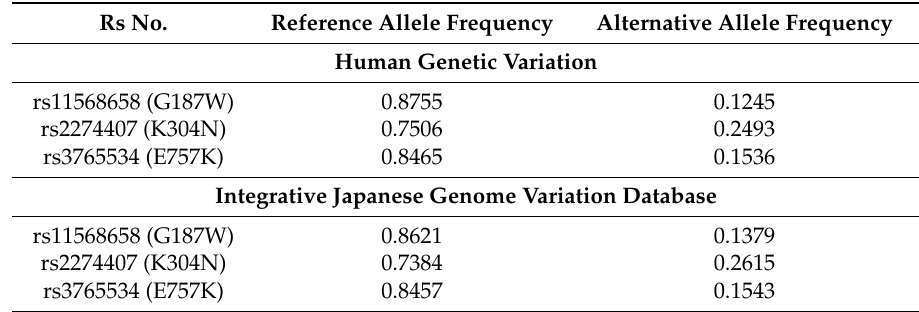
Table 1. Summary of allelic frequencies of major SNPs of human ABCC4 in the Japanese population. Rs No. Reference Allele